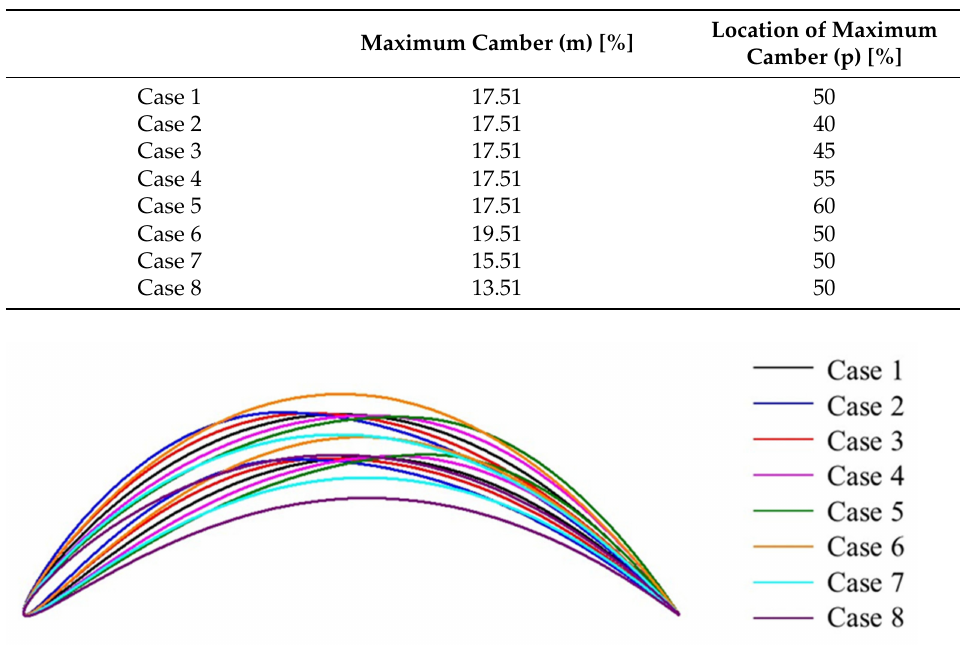
Table 1. Design parameters of the numerical analysis.